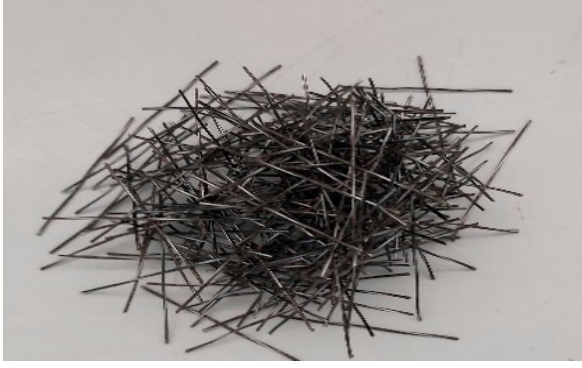
Figure 1. Grain size analysis of cement and dune sand.